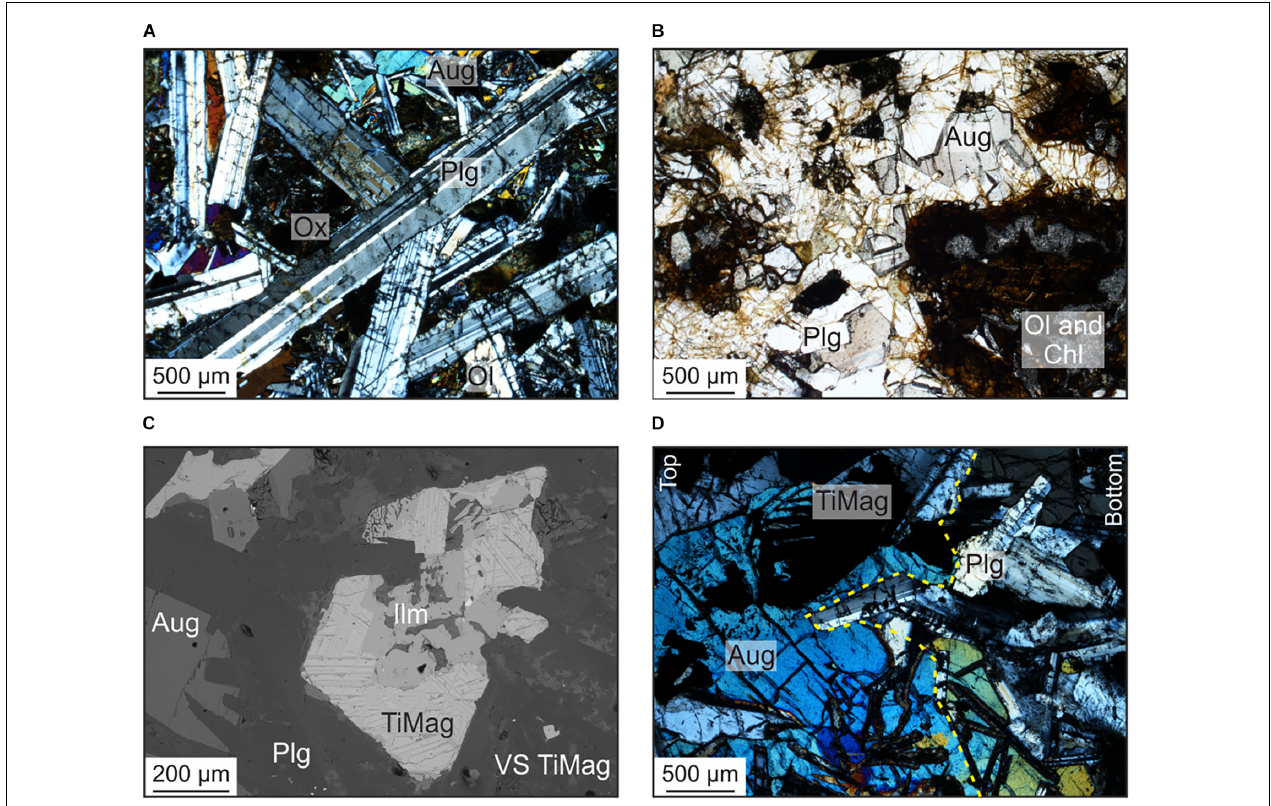
FIGURE 9 | Photomicrographs from optical microscopy viewed with crossed polarized light (A,B,D) and a backscattered electron SEM image (C) . (A) A stellate plagioclase (Plg) crystal from near the top of the sill (sample LMS-19-6 m), with ophitic augite (Aug) and unclassified oxides (Ox). (B) An olivine phenocryst (Ol) partly altered to chlorite (Chl) from the lower margin of the sill (sample LMS-6). (C) An ilmenite grain (Ilm) surrounded by titanomagnetite (TiMag) with exsolution lamellae, sampled from near the base of the sill (sample LMS-6). In the lower right corner, a small VS-SD sized crystal of interstitial TiMag can be seen which has crystallized from the interstitial melt. (D) Boundary of the crinanite with a gabbro lens indicated by yellow dashed line, with the left part of the image showing the gabbro lens (top) and the crinanite in the right part of the image (bottom). The sample is located near to the base of the crinanite sill (sample